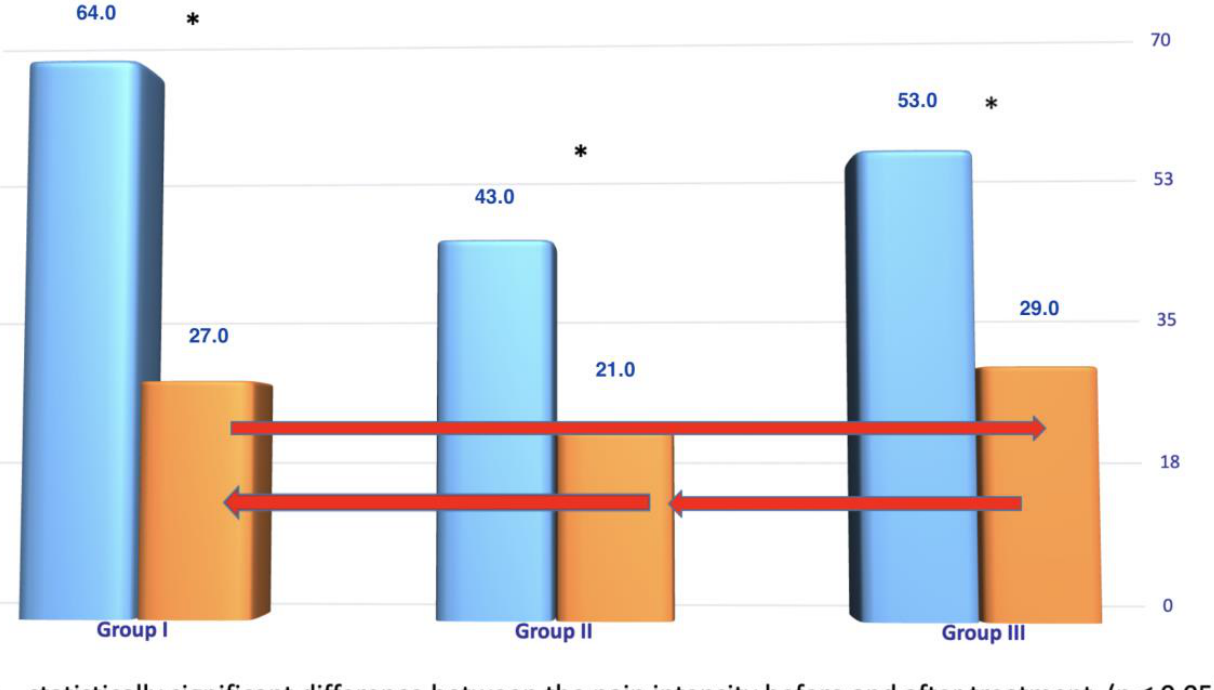
Figure 3. Comparison of pain levels on the VAS before and after therapy in each group and between groups after therapy (results in mm).